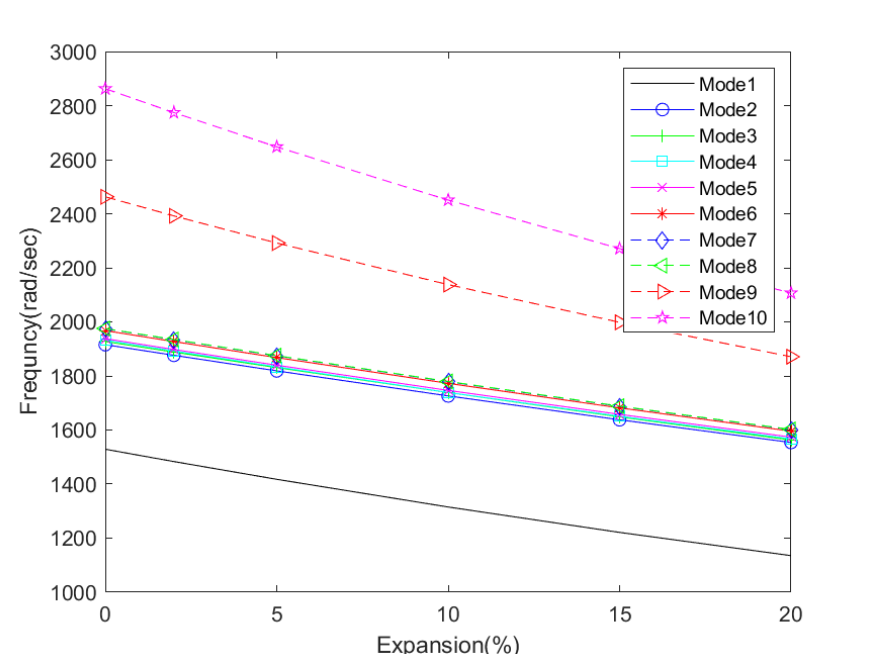
Figure 38. Changes in natural frequencies of Timoshenko beams with spanwise expansion.